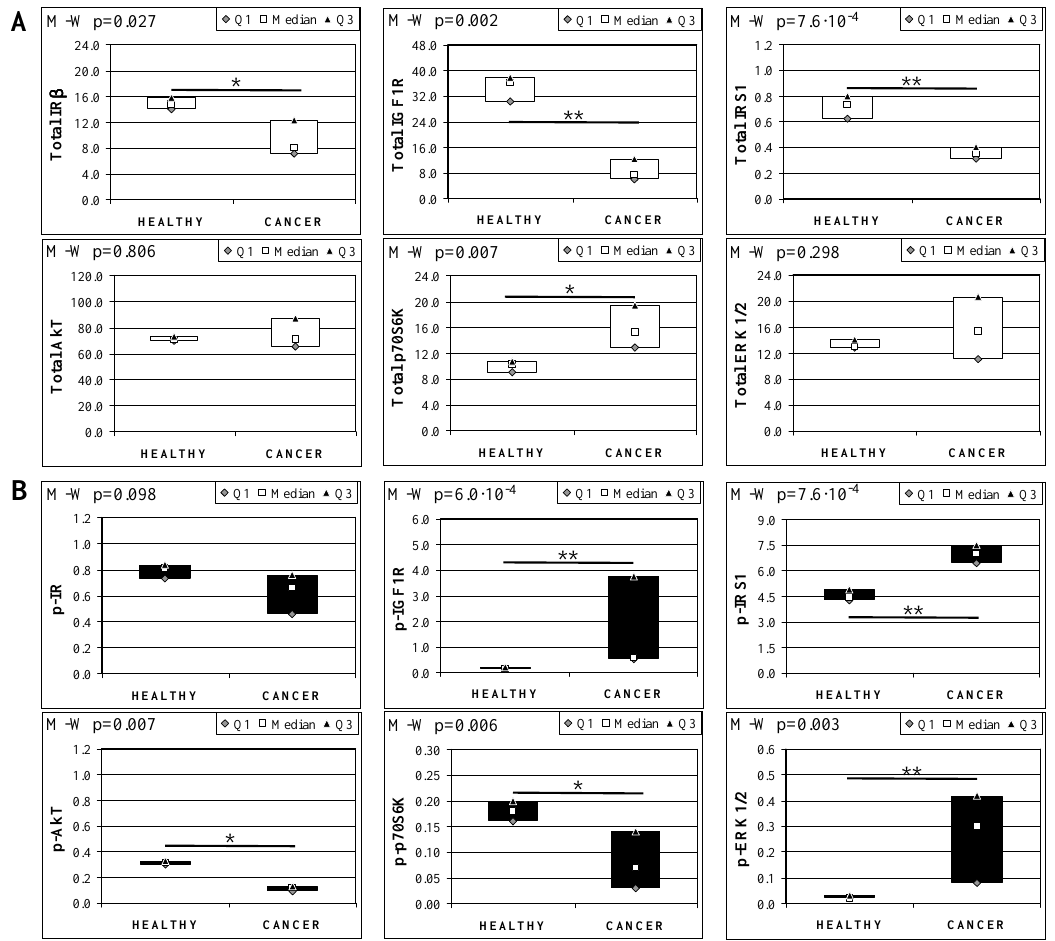
Figure 5. Insulin signaling in operated MKR male mice esophageal tissue. Data are represented as Median (Q1; Q3). Data obtained in operated mice affected by cancer were compared to strain-, sex-, and age-matched, non-operated animals (43 weeks). The Mann-Whitney U-test was performed to compare data distribution between the two groups of mice. A p -value lower than 0.05 was considered statistically significant: * p < 0.05; ** p < 0.005. ( A ) Total protein expression: the quantity of each total protein considered was expressed in ng/100 mg of total protein extracted by the distal mice esophageal segment. ( B ) Phosphorylated protein expression: the amount of the six phospho-proteins considered was expressed as phosphorylated Units for each ng of the corresponding total protein amount. Proteins were quantified by Luminex-xMAP Technology on the basis of a standard curve. Beta-tubulin expression was used as the internal loading